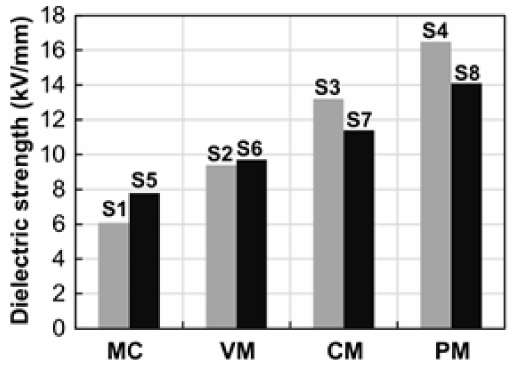
Figure 5. Dielectric strength results for different mixing procedures.